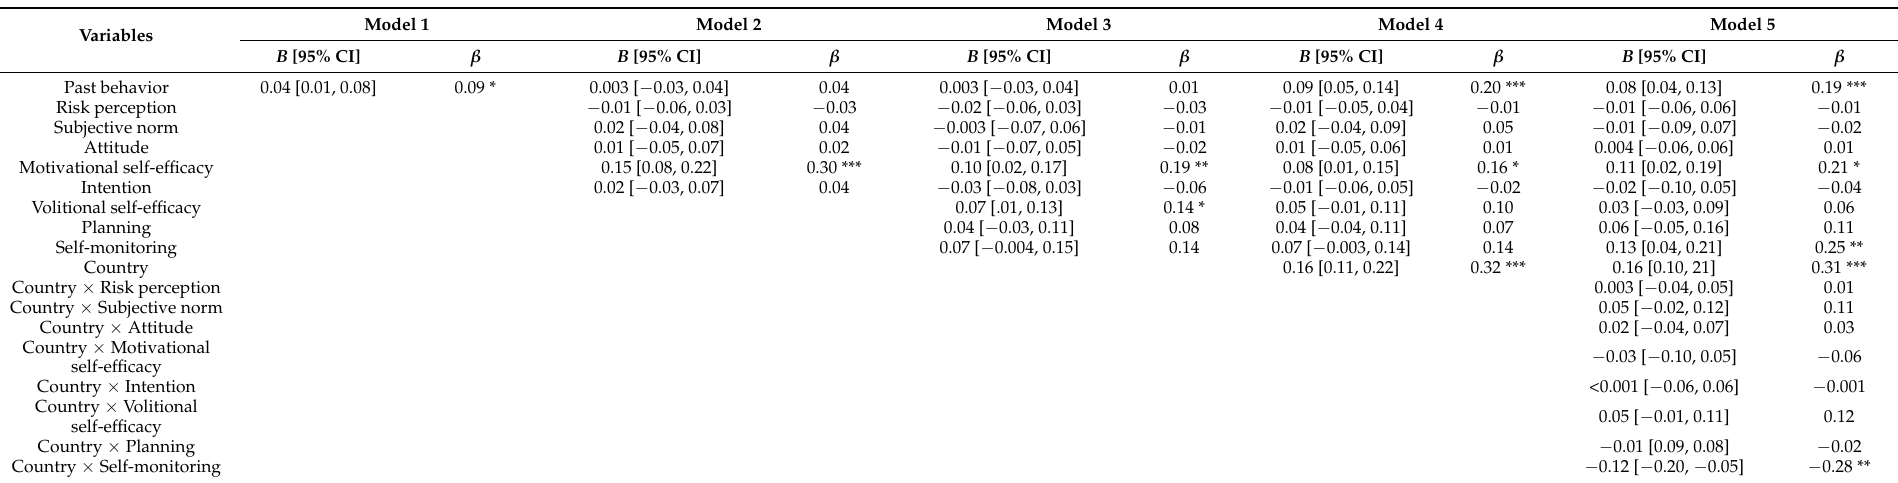
Table 4. Multiple hierarchical regression results for prediction of facemask wearing behavior ( n =